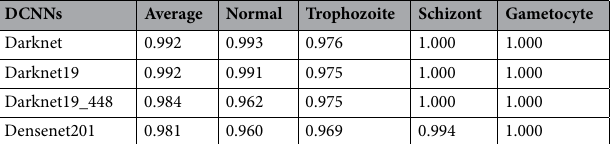
DCNNs Average Normal Trophozoite Schizont Gametocyte